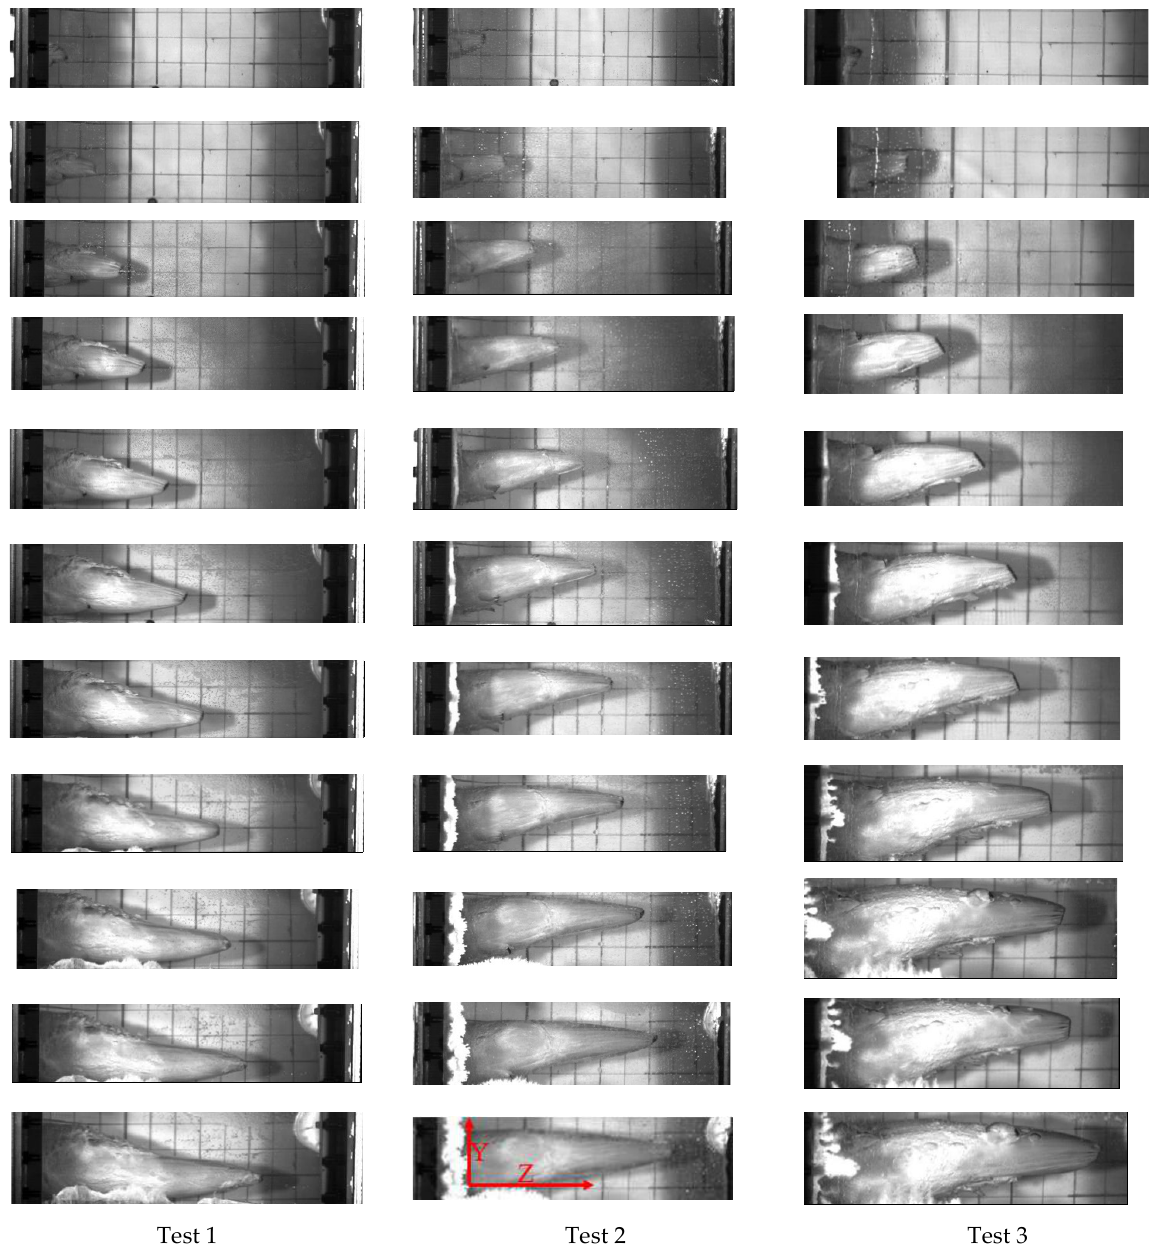
Figure 8. Photographs of underwater penetration process.